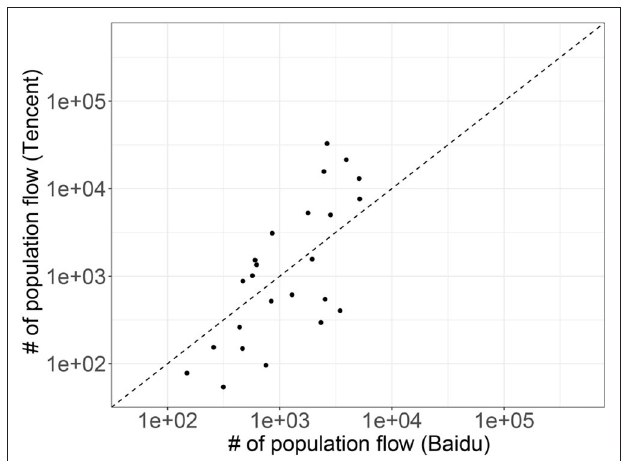
FIGURE 3 | Log maximum likelihood estimation for λ , based on data sourced from Baidu and Tencent. which follows a binomial distribution (Equation 2), based on Baidu and Tencent data, see Equation (7). To estimate the number of cases exported from Wuhan, the model used estimated the total number of COVID-19 cases infected in Wuhan ( λ ) from Equation (4). p i is the probability that we will find any